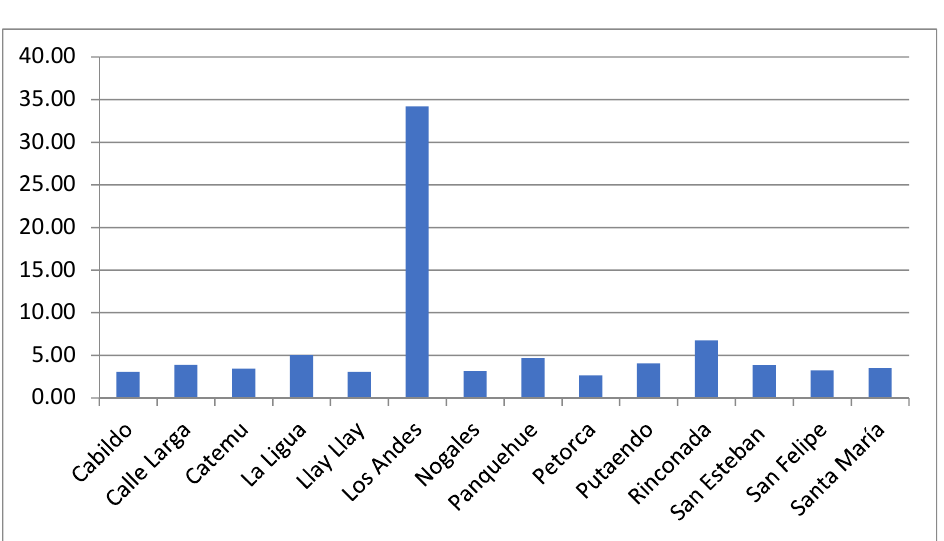
Figure 9. Employment variation in the primary, secondary, and tertiary productive sectors, 1992–2017.